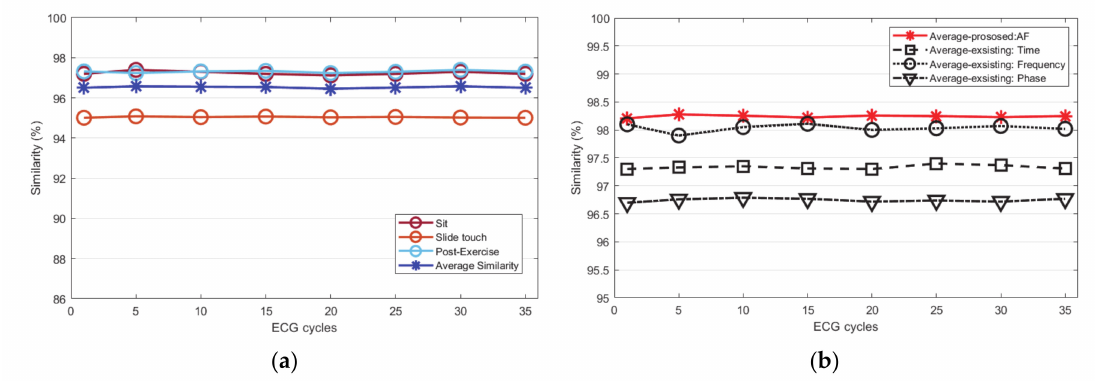
Figure 11. Euclidean distance similarity performance analysis: ( a ) similarity of each status before normalization ( b ) similarity after normalization (proposed method, existing